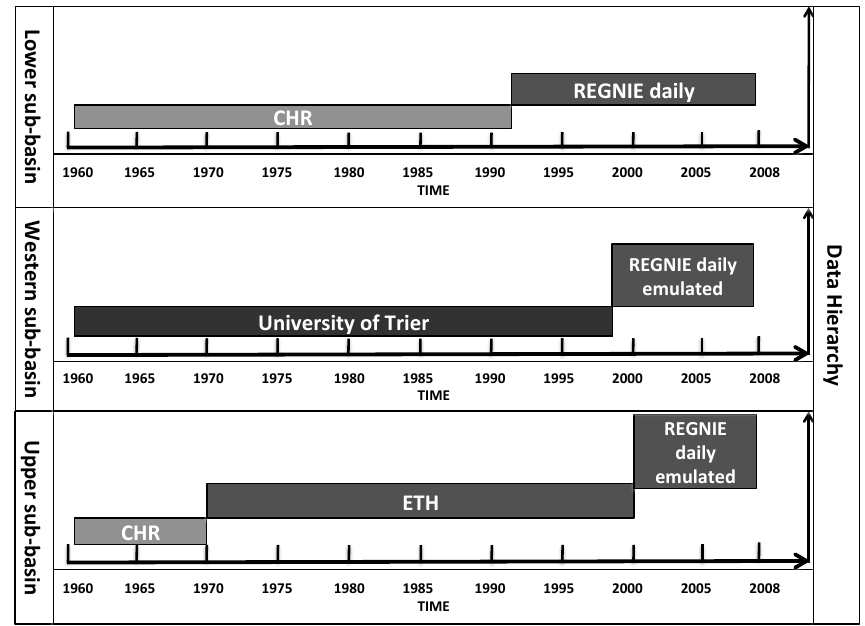
Fig. 2. Schematic representation of the data sets used to construct CHR08 for each of the major